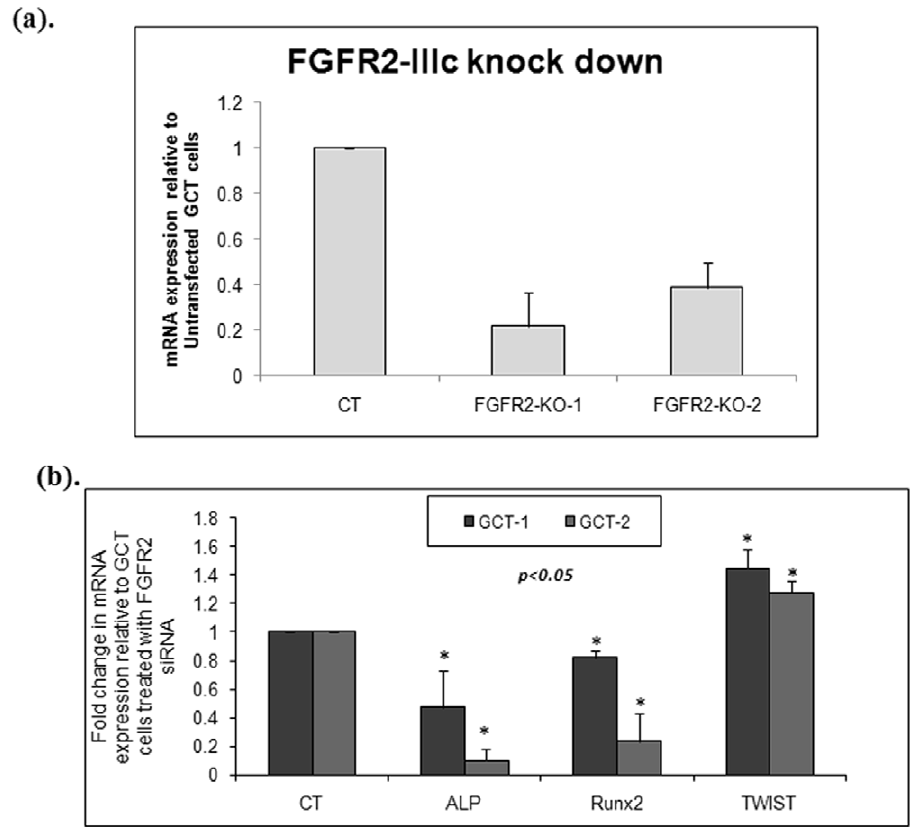
Figure 6. The effect of FGFR-2IIIc siRNA on mRNA expression in the GCT stromal cells. ( a ). FGFR2 siRNA transfection resulted in a 70% decrease in FGFR-2IIIc expression in GCT stromal cells. ( b ). Quantitative RT-PCR was used to represent the expression of ALP, Runx2 and TWIST following FGFR-2IIIc knockdown (KO) in GCT cells. Results are the average of three replicate experiments. FGFR-2IIIc knockdown resulted a 1.5 fold increase of TWIST1 expression and a significant decrease in Runx2 and ALP expression (p , 0.05).